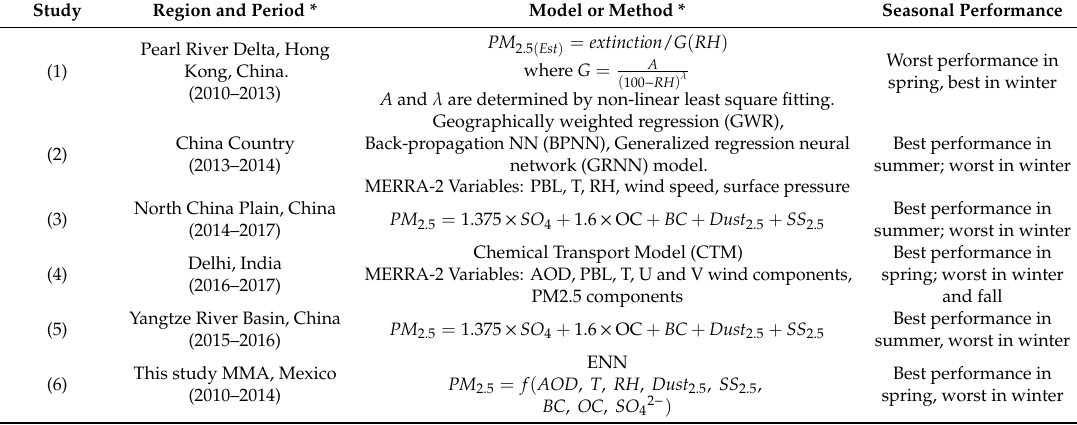
Figure 7. Statistical performance obtained using the ensemble NN to estimate monthly PM 2.5 means over the MMA from January 2010–December 2014. Table 3. Previous studies that used MERRA-2 aerosol data to estimate PM 2.5 concentrations and compared them with monthly averaged ground-based concentrations or analyzed seasonal variations.